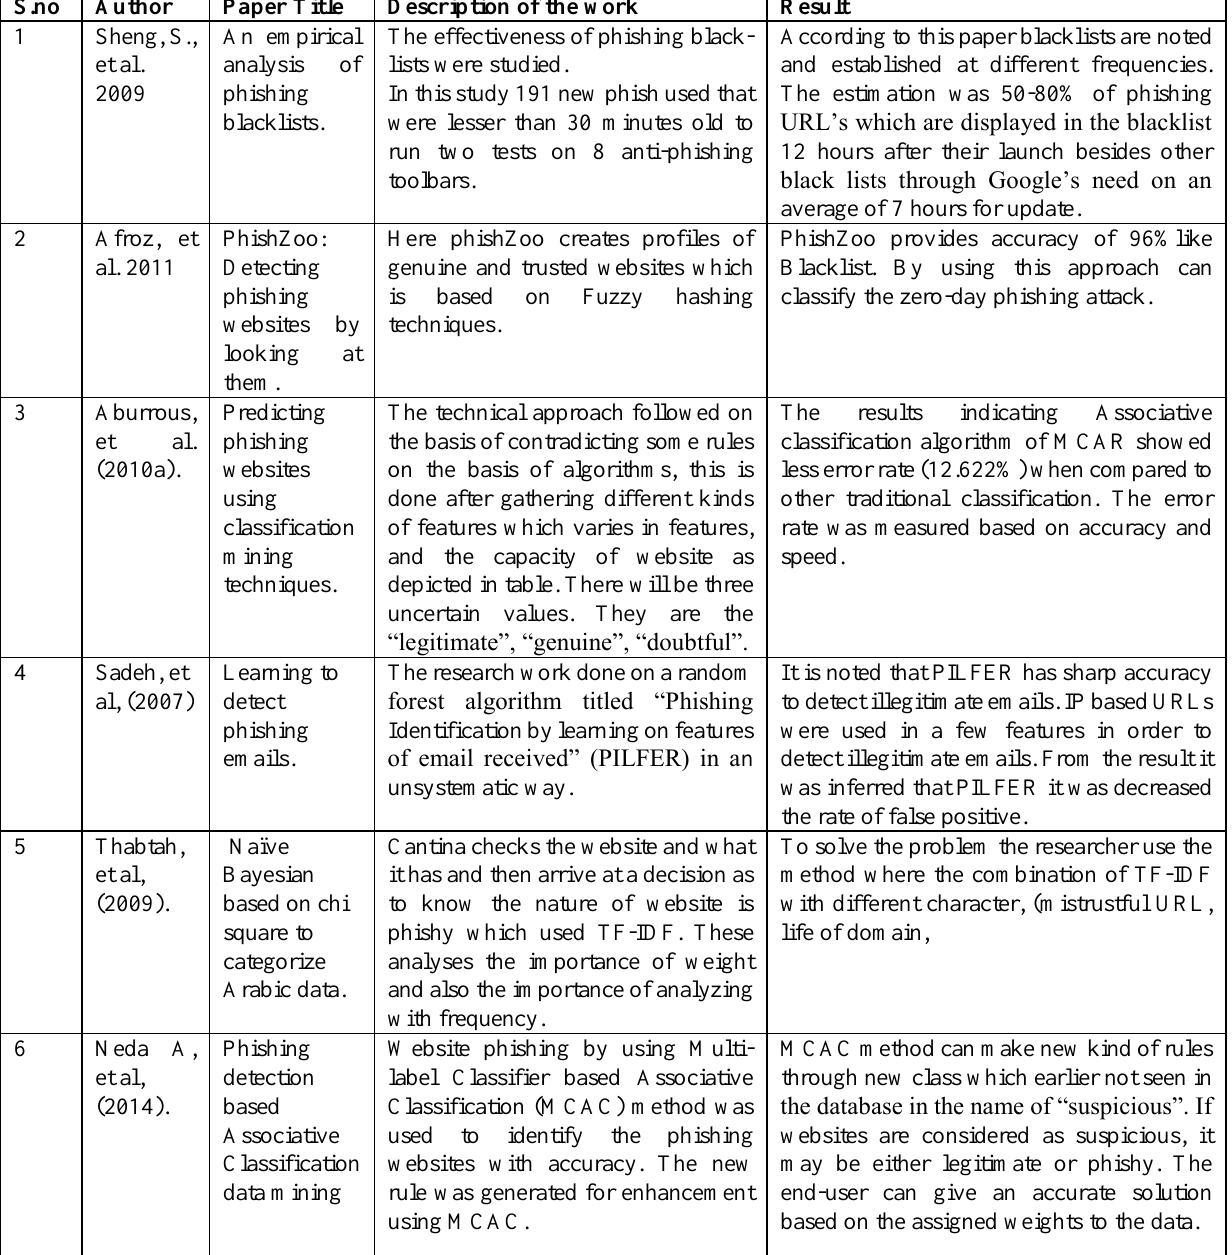
Table 1. Comparative and analysing